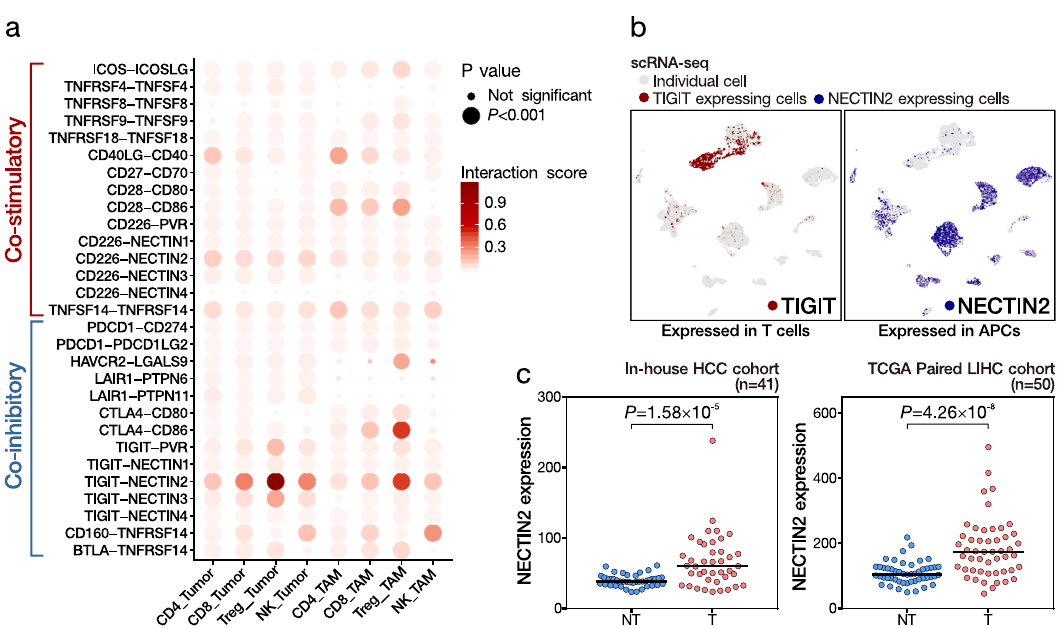
Fig. 4 Immune checkpoint analysis in HCC implicates TIGIT – NECTIN2 interaction. a We examined the immune checkpoint interactions between lymphocytes and APCs (tumor cells and TAMs) and identi fi ed the prominent interaction via the TIGIT – NECTIN2 axis (circle size indicates the statistical signi fi cance and circle color indicates the level of interaction). The empirical P value was estimated by 1000 imputations. b The expression of TIGIT and NECTIN2 was respectively enriched in T cells and APCs. c Upregulation of NECTIN2 was detected in HCC tumors, as compared to non-tumorous livers in both in-house and TCGA datasets. Student ’ s t test (2-sided). Source data are provided as a Source Data fi